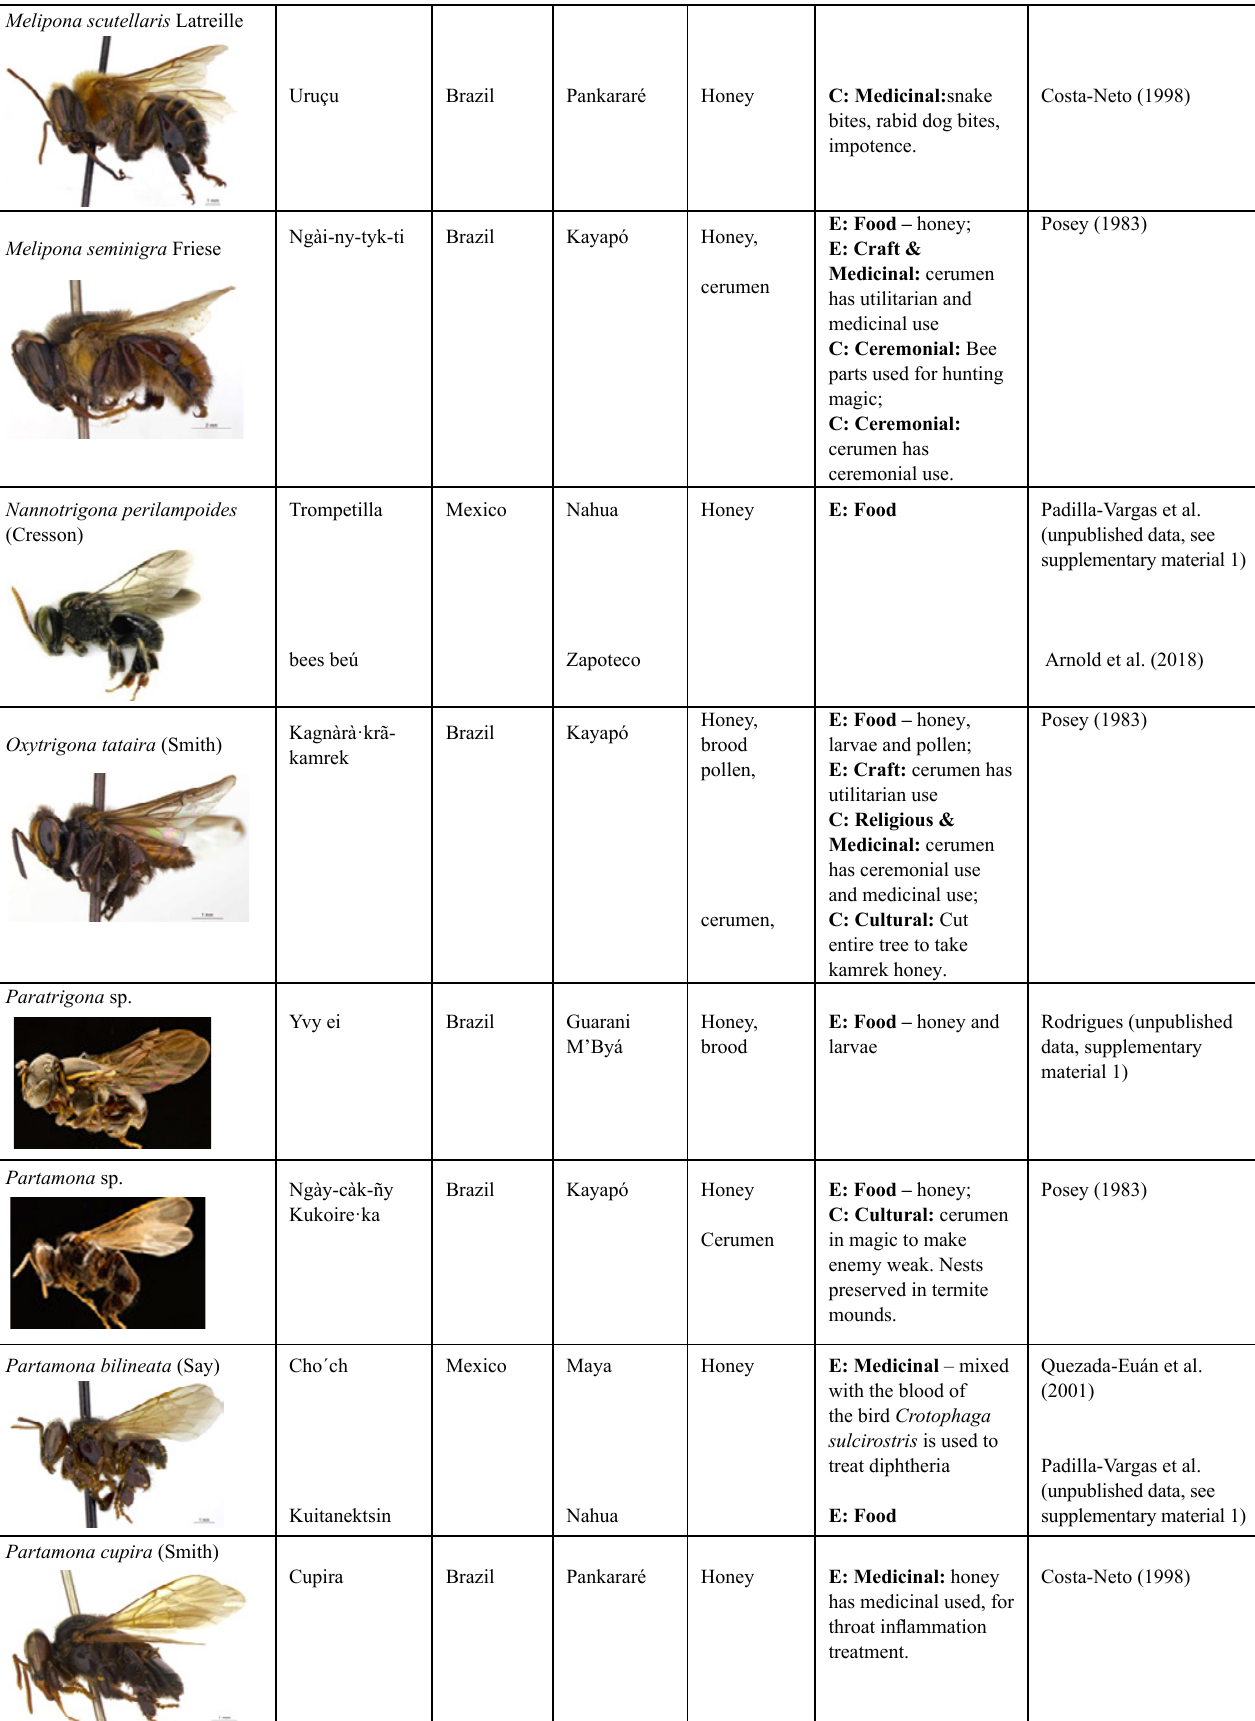
C: Medicinal: snake bites, rabid dog bites, impotence.